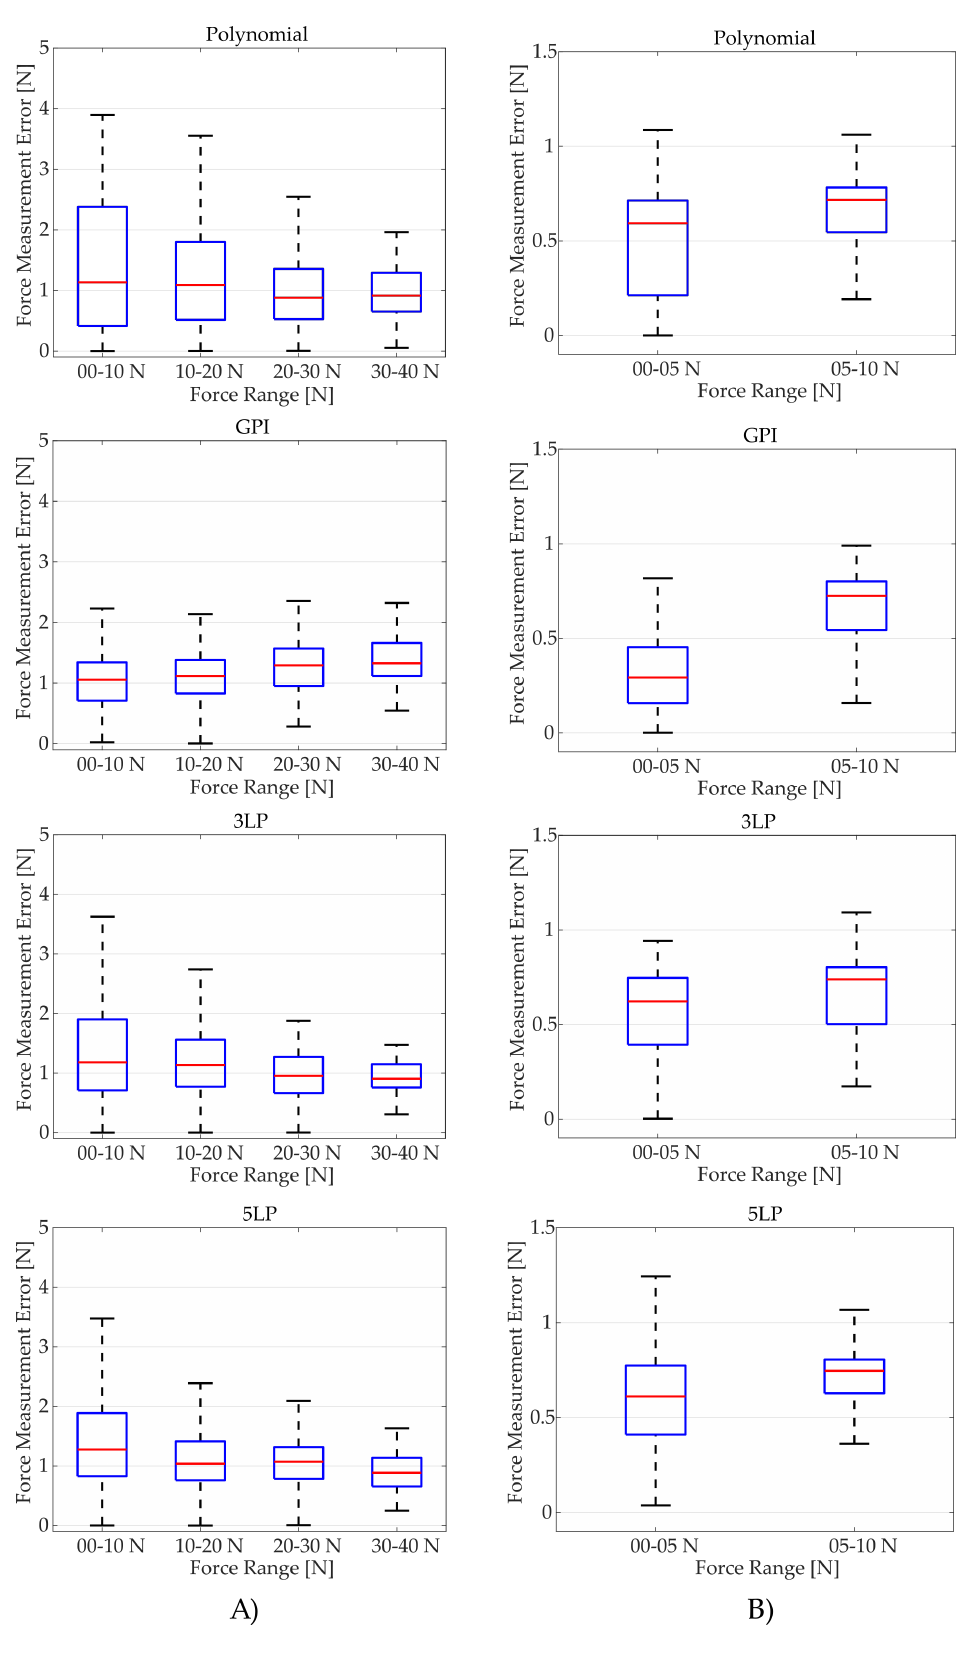
Figure A3. Error distribution computed for the Random Signal test and range of force. Where ( A ) corresponds to the data of the PLA based sensor and ( B ) to the steel based